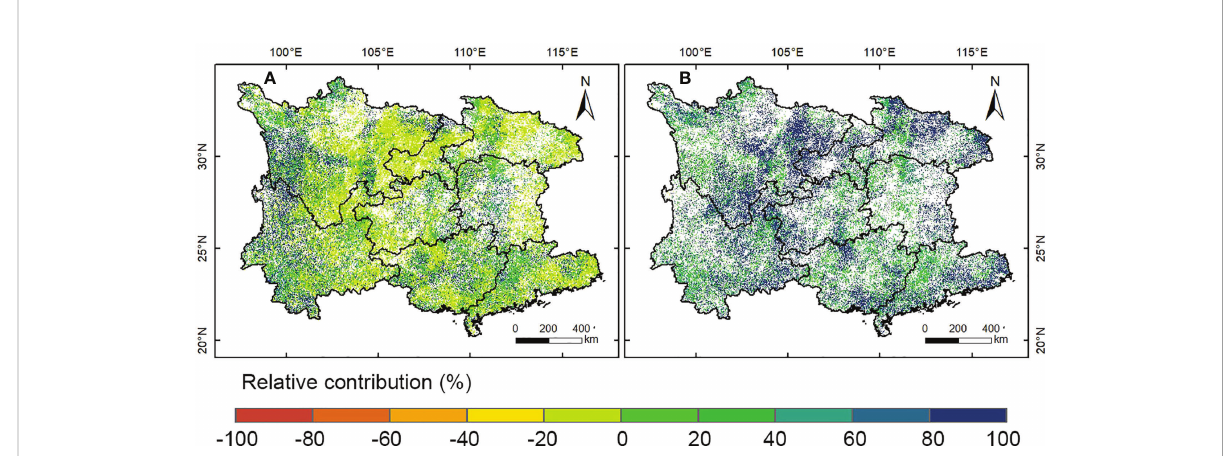
FIGURE 5 Spatial distribution of relative contribution of climate change and human activities in regions with signi fi cant NDVI change ( P < 0.05). (A) Climate change, and (B) human